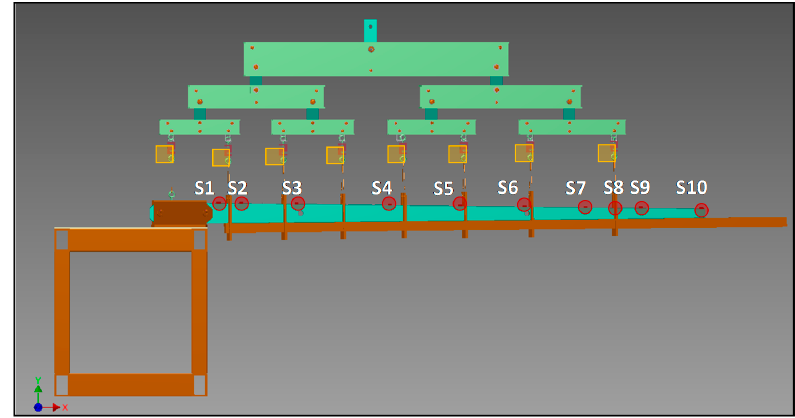
Figure 1. Schematic of the “whiffle-tree” loading apparatus to simulate distributed loading. Load cell locations are indicated by yellow boxes, while acoustic emission (AE) sensor locations are indicated as red circles.